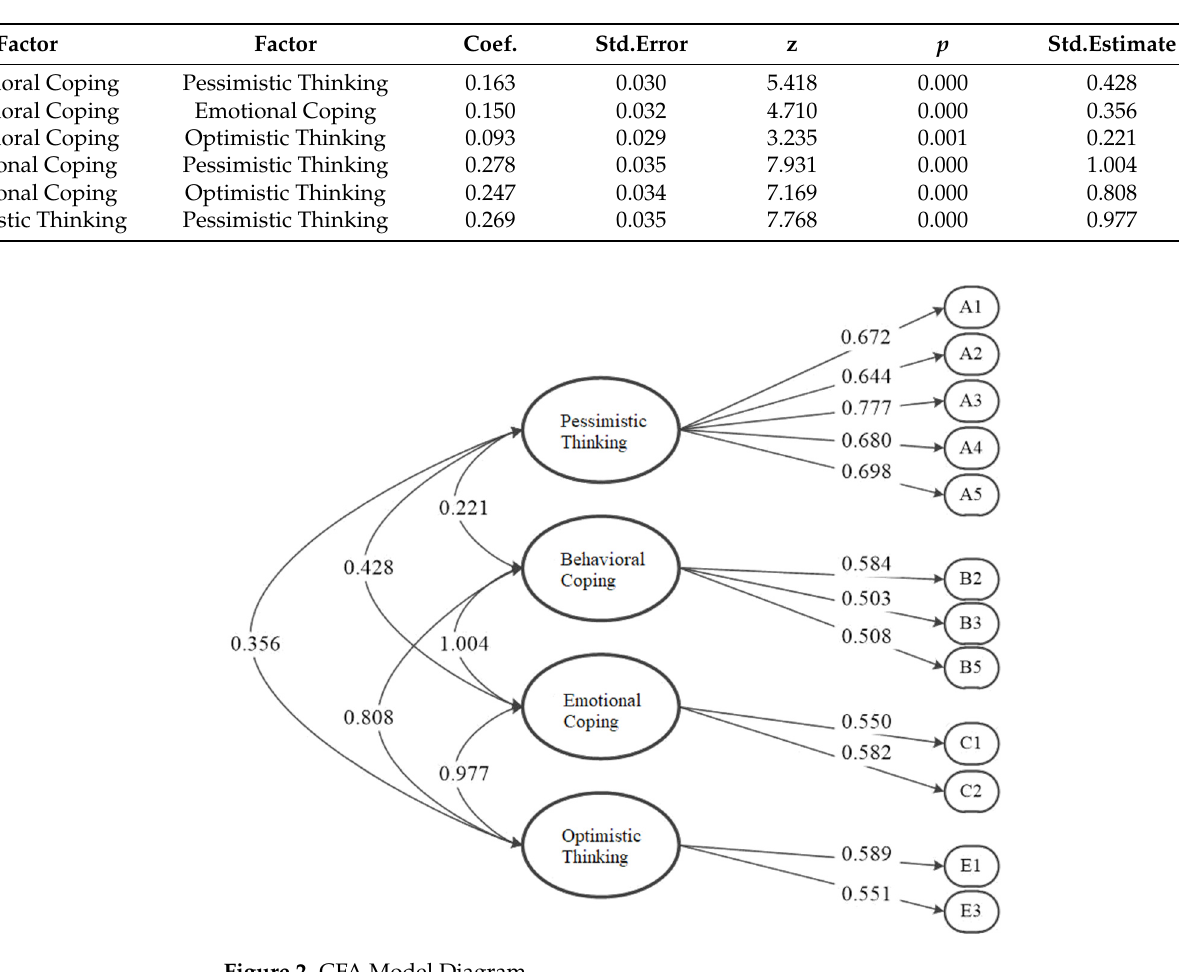
Table 11. The Factor covariance table.